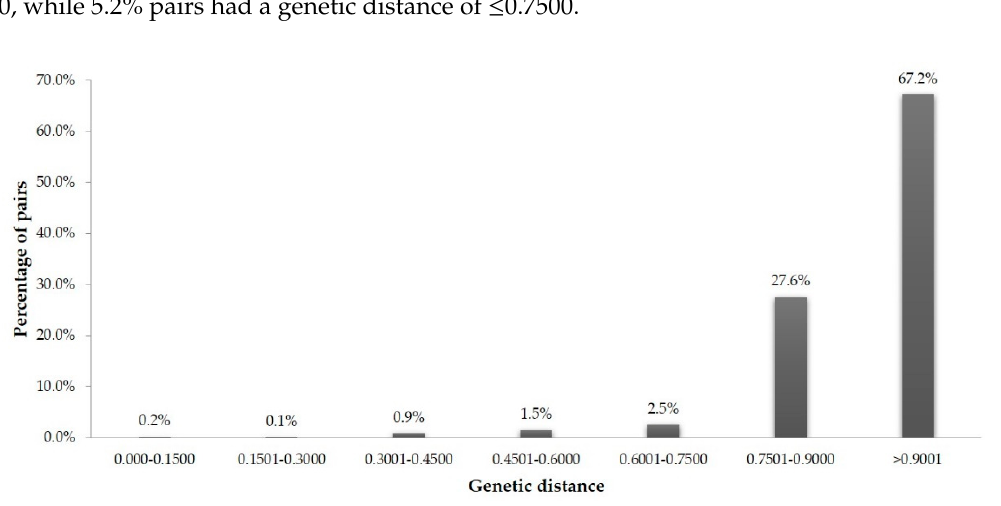
Figure 4. Distribution of pair-wise Roger’s genetic distance for 99 Brachiaria ecotypes based on 24 simple sequence repeats